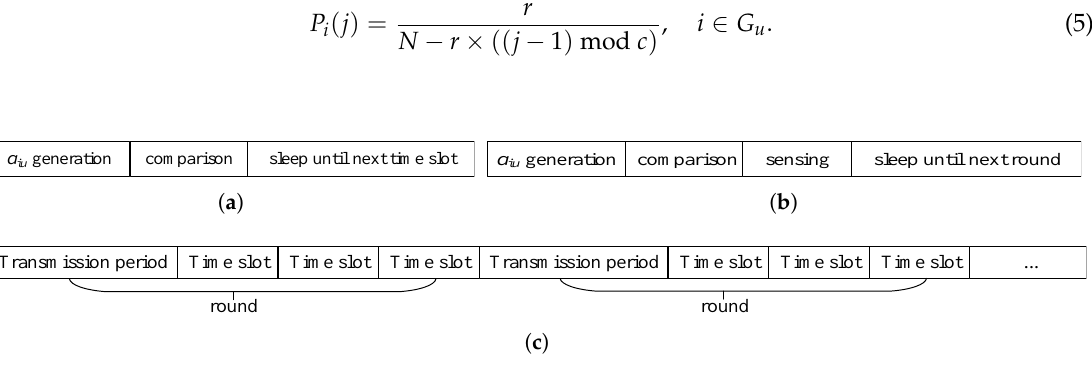
Figure 2. Time scheduling. ( a ) A time slot of non-sensing nodes. ( b ) A time slot of sensing nodes. ( c ) Time scheduling of the network when c =